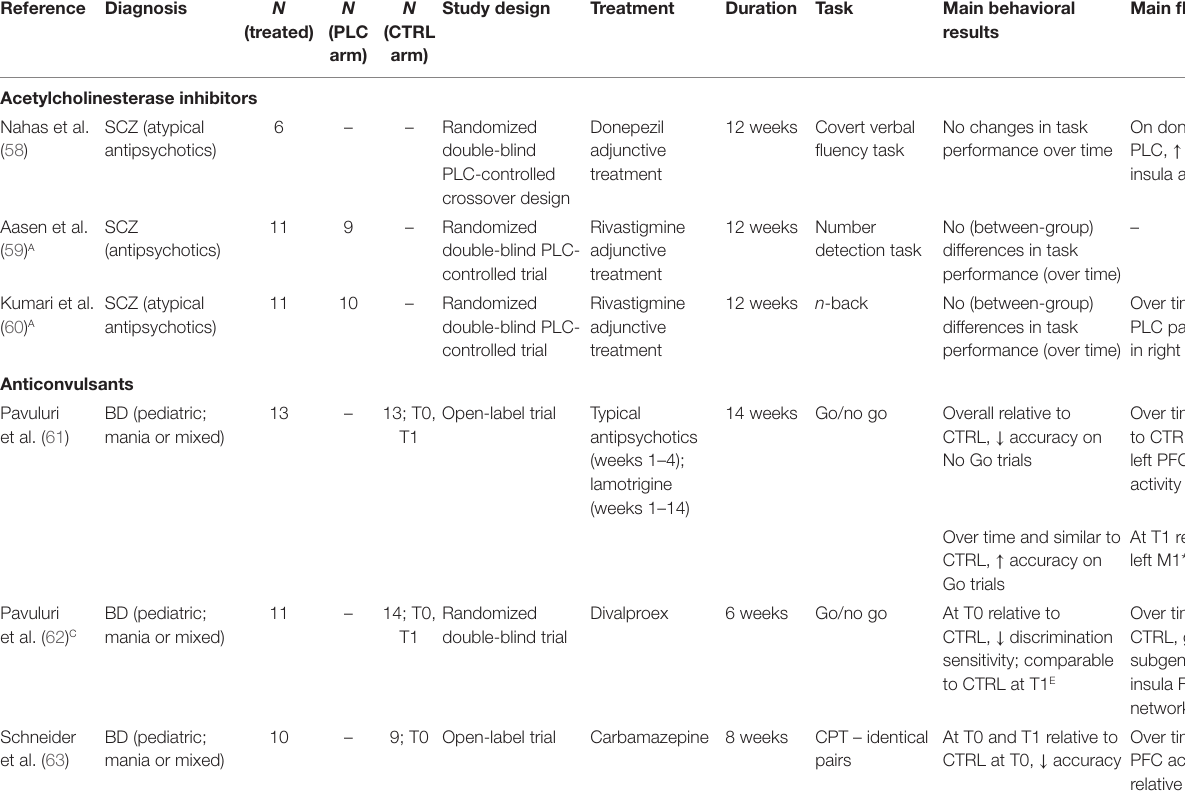
TABLe 1 | Overview of the effect of pharmacological agents on the fronto-cingulo-parietal cognitive control network. Reference